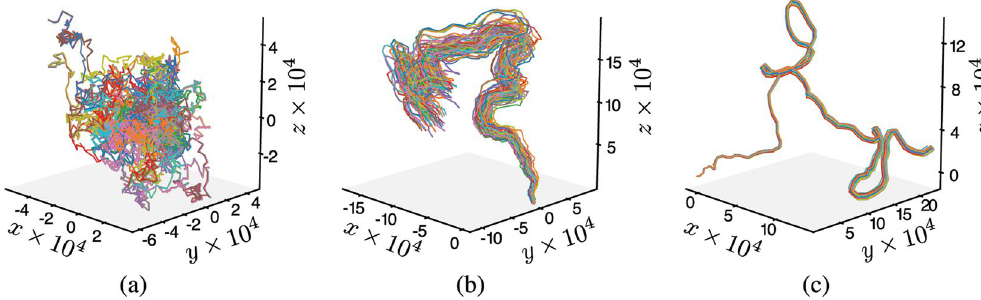
Figure 2. Typical trajectories of systems moving in open space with N = 512 particles, topological short-range interactions, fixed noise intensity η = 0.15, initial density ρ 0 = 0.3 and different values of κ . ( a ) For κ = 0 the system is not able to organize into an ordered state even when ρ 0 and η take values corresponding to the ordered phase of the standard Vicsek Model with periodic boundary conditions. ( b ) For κ = 0.01 the system becomes ordered and forms a spatially localized group. Note the noise-driven turns performed by the entire group. ( c ) For κ = 0.1 the system remains more compact and ordered for longer periods of time. All the trajectories were computed for 10 6 time steps.